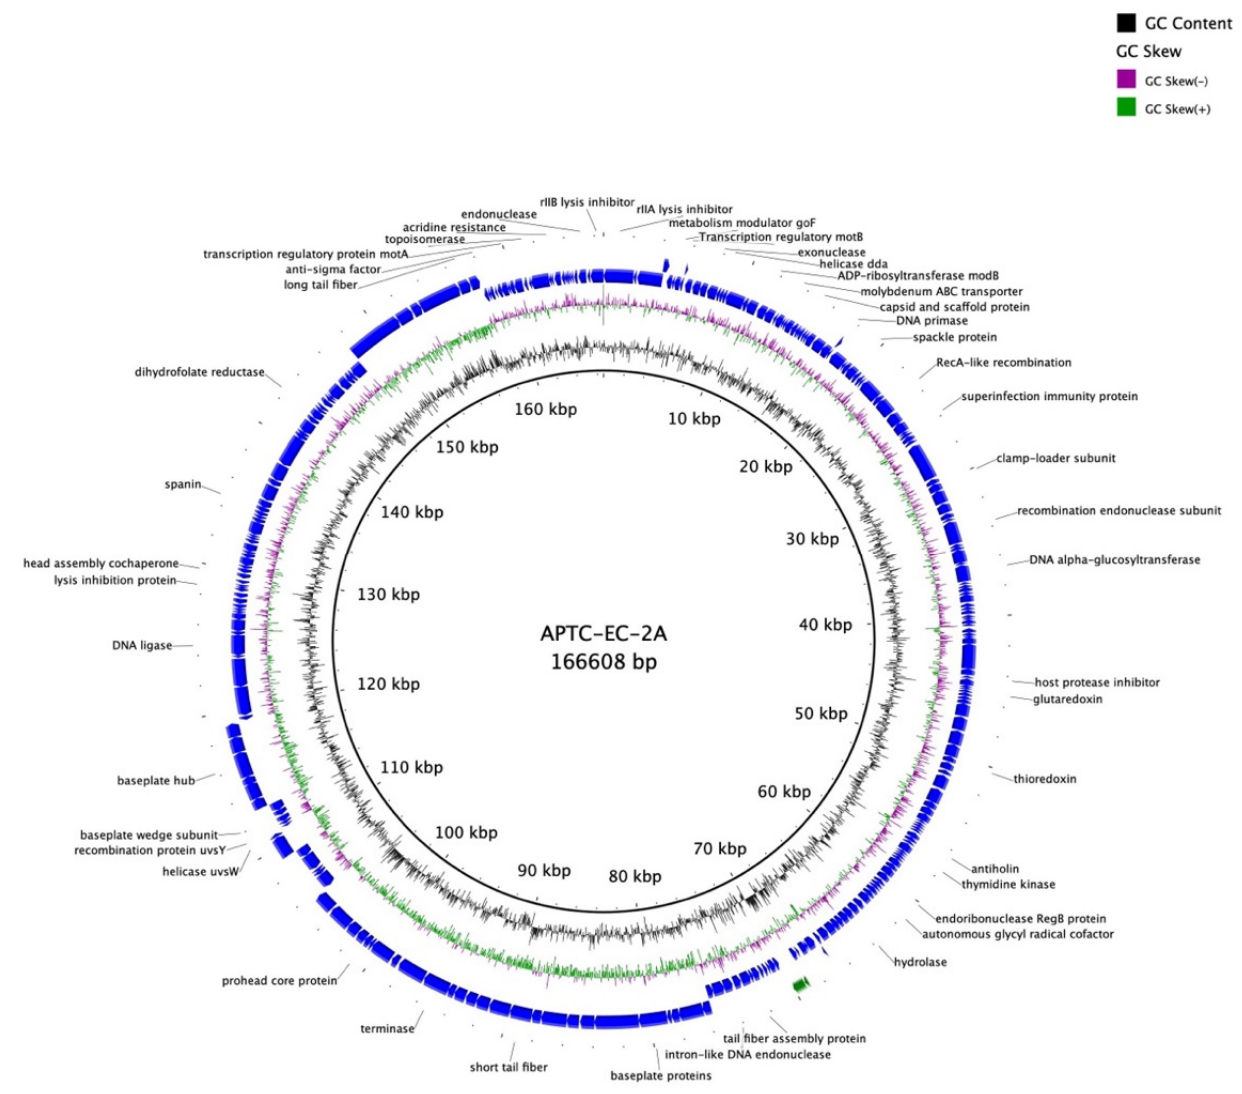
Figure 6. Map of the genomic organization of bacteriophage APTC-EC-2A. The Open Reading Frames with predicted annotations are indicated with blue arrows.